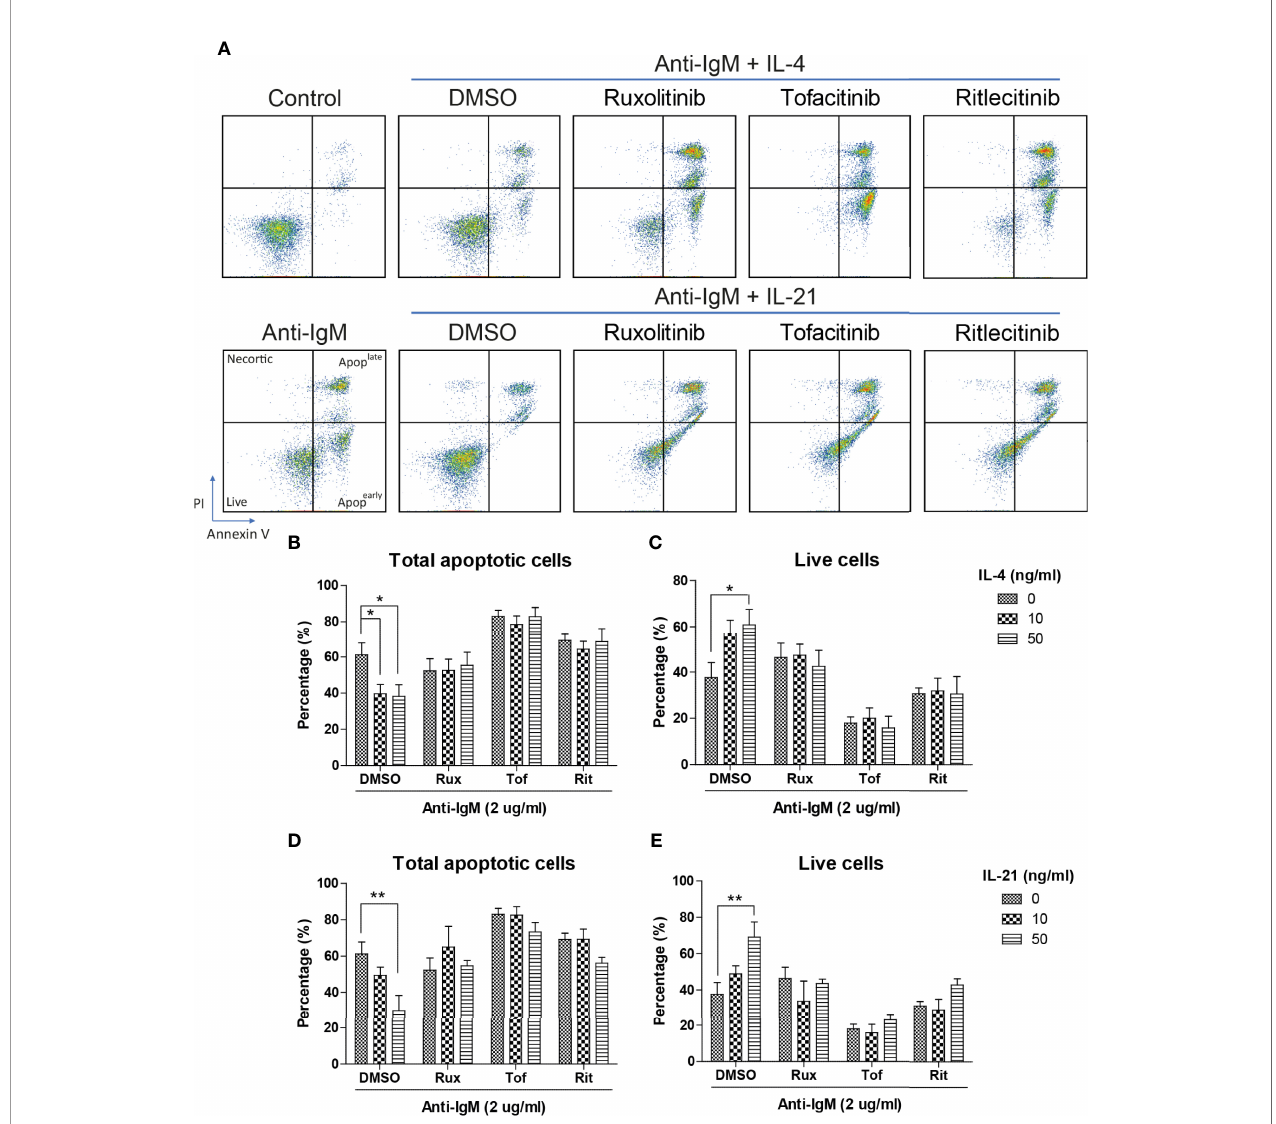
FIGURE 6 | JAK inhibitors suppressed IL-4 and IL-21 rescues of B cell apoptosis. (A) Representative images showed that all JAK inhibitors suppressed IL-4 and IL-21 effects in suppressing apoptosis induced by anti-IgM challenge. Quanti fi cation showed that application of three JAK inhibitors re-induced apoptotic population and reduced live cell population even in the presence of IL-4 (B, C) and IL-21 (D, E) treatment. All groups shown in the fi gures were treated with 2 µg/ml anti-IgM for 48 hours. **p < 0.01,*p < 0.05 as compared to indicated DMSO control group by two-way ANOVA, N =